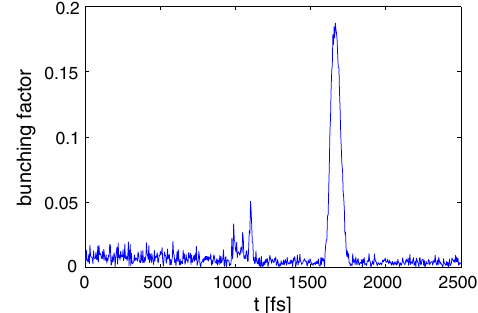
FIG. 7. Bunching factor distribution along the electron beam at the entrance to the radiator of the second stage. The microbunch- ing in the disturbed part of the electron beam (used in the first stage) is nearly smeared out by the shifter and DS2. The bunching factor of this part is much smaller than that of the fresh